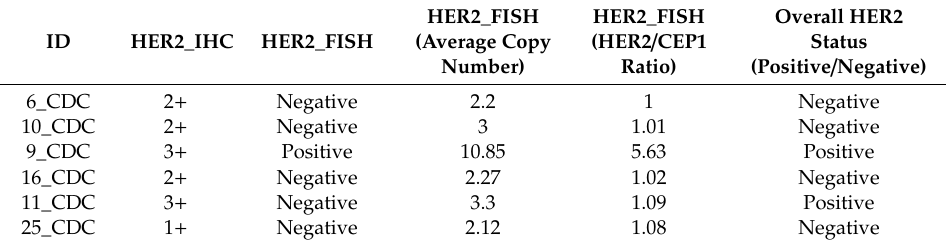
Table 2. HER2 IHC and FISH results in IHC-HER2 + collecting duct carcinoma (CDC) patients.